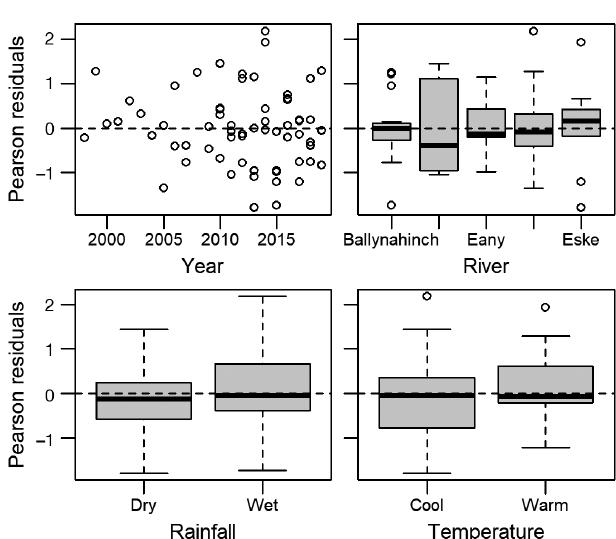
Fig. 3. Residuals for Model 12 of salmon louse pressure and associated sea trout runs (see Tables 2 & 3) plotted against some variables not included in this